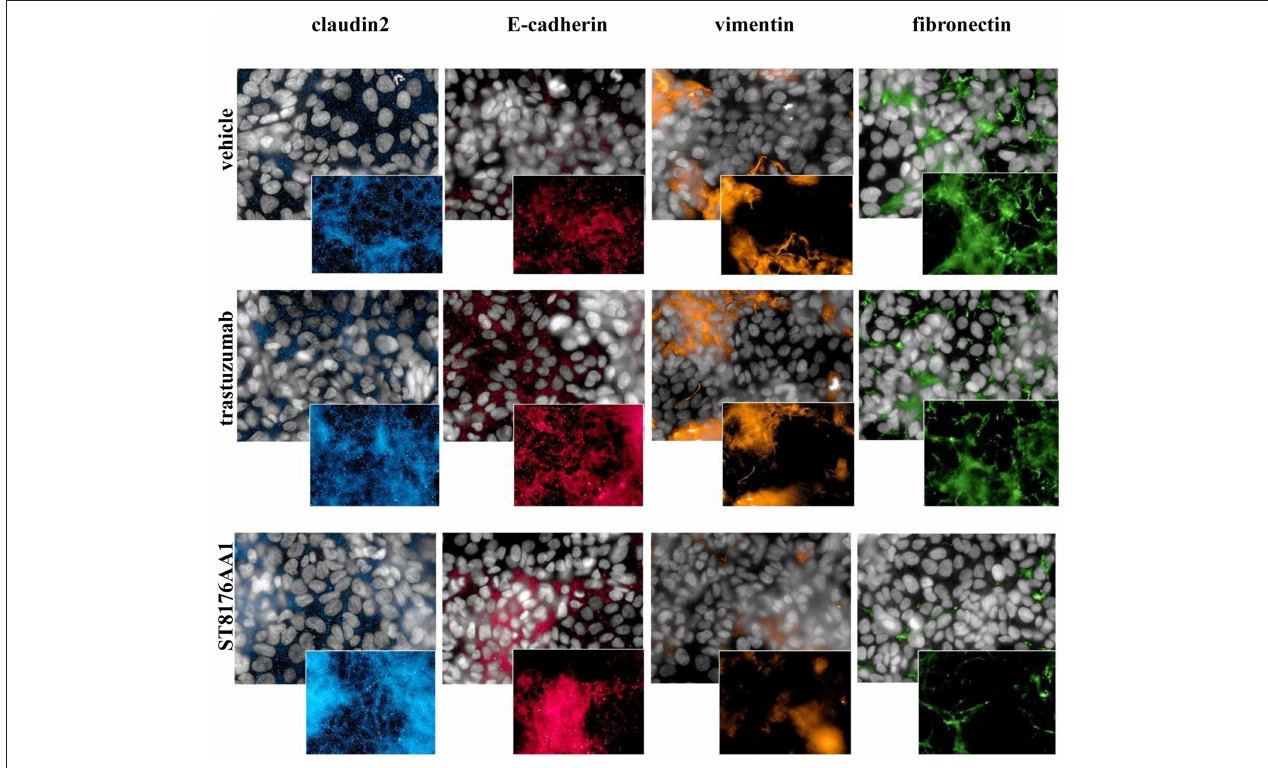
FIGURE 6 | ST8176AA1 induces reversal of epithelial/mesenchymal transition in tumor cells. HCS imaging analysis showing that SKOV3 cells treated with ST8176AA1 exhibit increased expression of the claudin2 and E-cadherin (epithelial) proteins and reduction of vimentin and fibronectin (mesenchymal) proteins. ST8176AA1 and trastuzumab were used at 15 µ g/mL (3 days incubation). In all panels, insets show specific fluorescence signals within the cells. Draq5 dye staining of nucleus (gray). Each image is representative of at least five fields of duplicate wells. Magnification 60X. Data are from one representative experiment out of